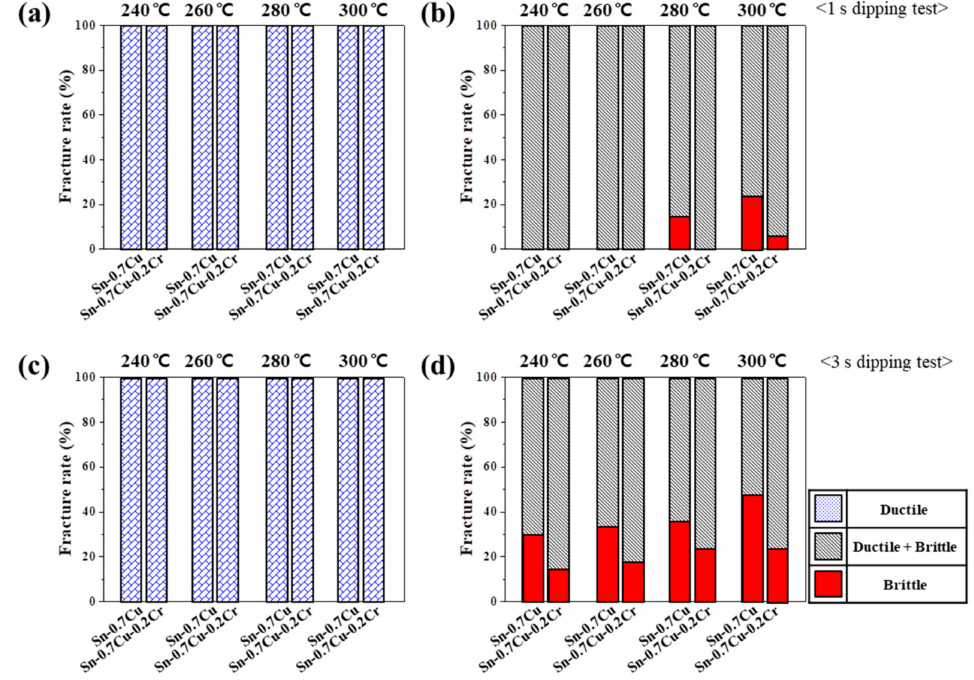
Figure 15. Statistics of the fracture modes of the solder joints at shear speeds of ( a , c ) 0.01 and ( b , d ) 1